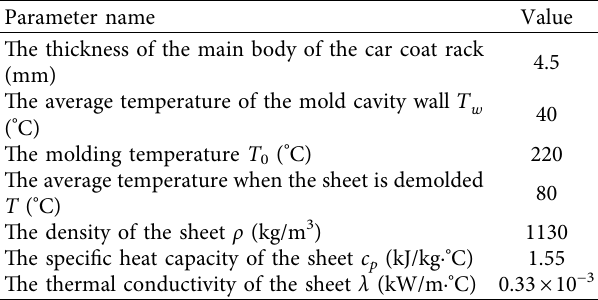
Table 4: The value of process